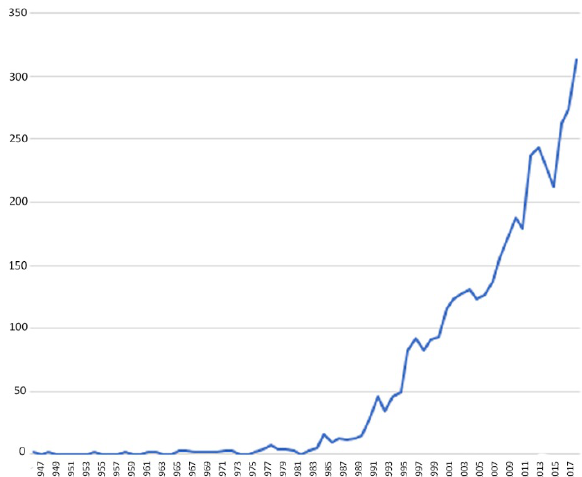
Figure 2 Number of oldest-old research articles by